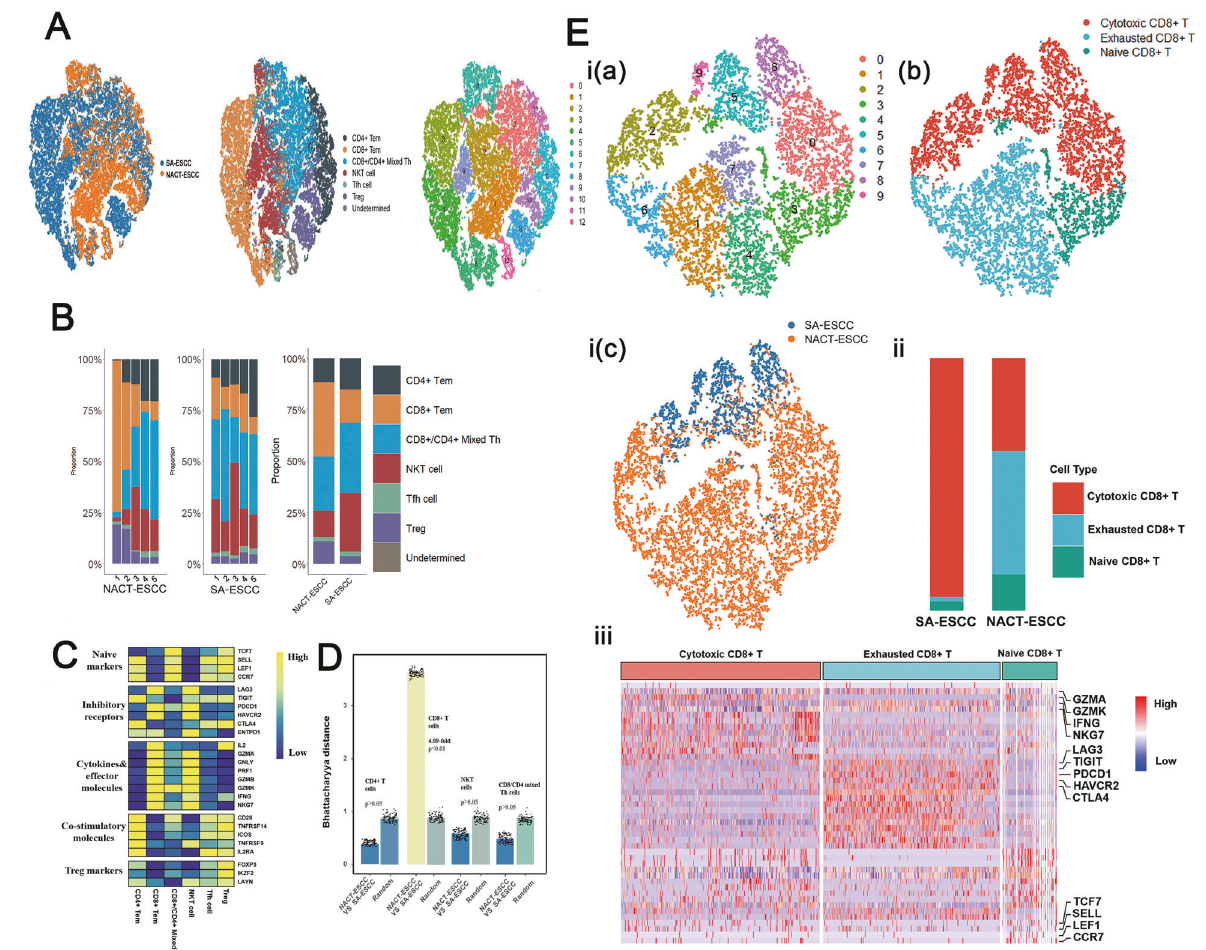
Fig. 7 The scRNA Pro fi les for T cells in SA-ESCC and NACT-ESCC. A The TSNE plot of T cells in SA-ESC and NACT-ESCC samples. B The proportion of each T cell subtypes in SA-ESCC and NACT-ESCC samples. C Average expression of selected T cell function-associated genes of naïve markers, inhibitory receptors, cytokines and effector molecules, co-stimulatory molecules, and Treg markers in each T cell subtype. D Quanti fi cation of differences between major T cell subtypes in NACT-ESCC and SA-ESCC. Each dot stands for a subsample of 500 cells from PCA space for NACT-ESCC and SA-ESCC or a sample of 500 cells from a random group. The height of the bar is the mean of the subsample. E The overview of CD8 + T cells. I, the TSNE plot of CD8 + T cells with each colored by its clusters (a), the associated cell type (b), and sample type of origin (SA-ESCC or NACT-ESCC) (c). II, the proportion of each CD8 + T cell subtypes in SA-ESCC and NACT-ESCC samples. III, heatmap of marker genes of each CD8 + T cell